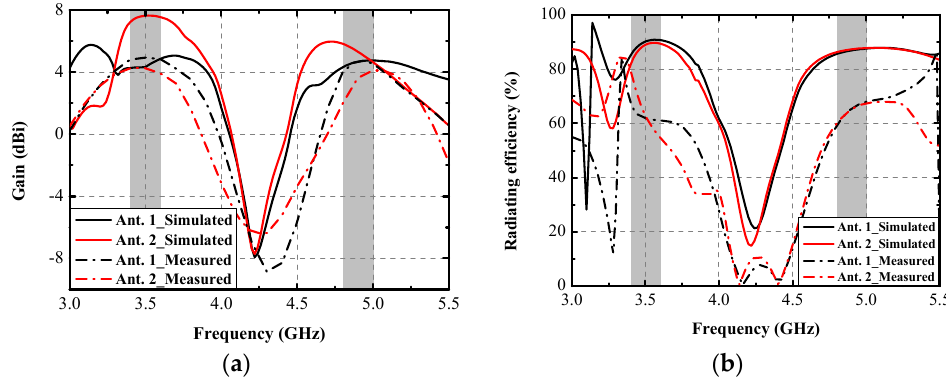
Figure 11. Simulated and measured ( a ) gain and ( b ) radiating efficiency of Ant. 1 and Ant. 2.